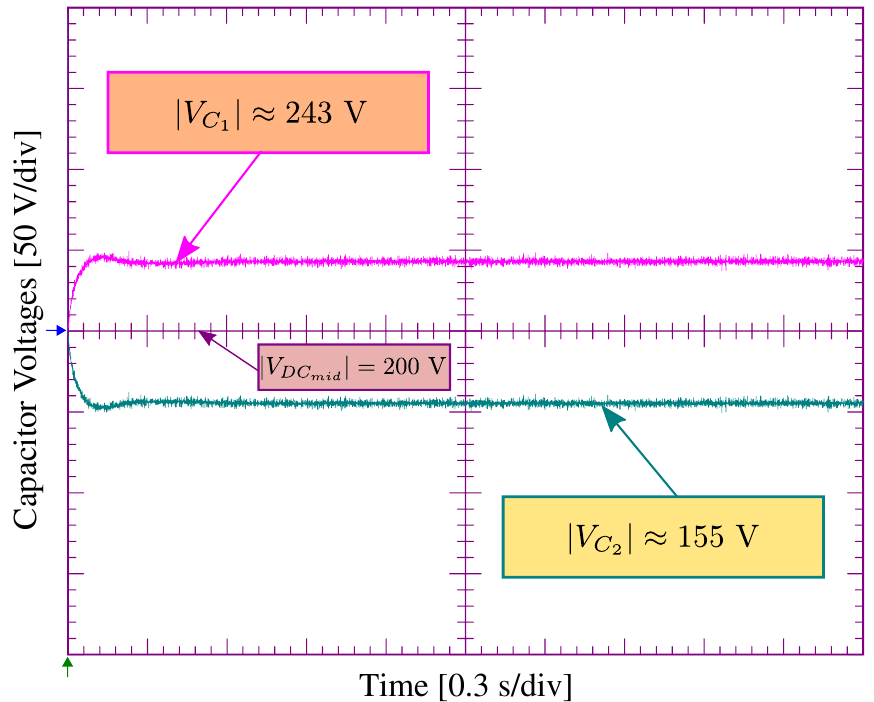
Figure 8. DC-link capacitor voltages of the PMSM drive under classical alignment procedure at start-up. Operating at: 0.25 pu d -axis voltage and zero q -axis voltage with 10 kHz switching frequency under fan type loading condition.